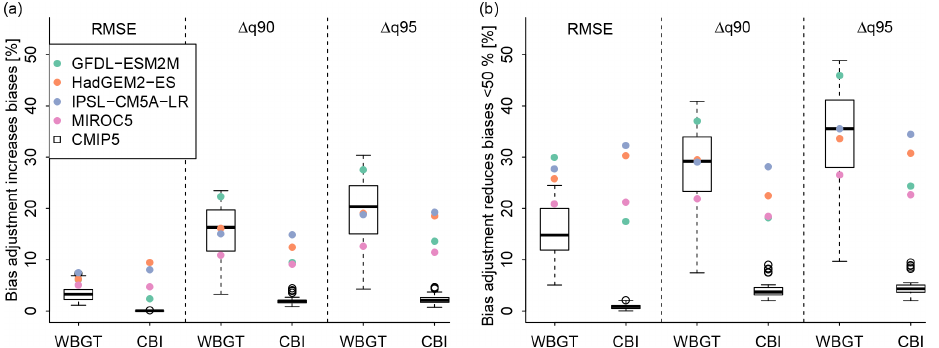
Figure 3. Fraction of grid points for which UQM increases bias (a) or does not result in a reduction of more than 50% in biases (b) of modeled hazards. Box plots represent the CMIP5 multimodel ensemble after UQM and highlight the median (horizontal line), interquartile range (box), 1.5 times the interquartile range (whiskers) and outliers (points). Colored dots represent the results for the ISIMIP2b bias adjustment applied to the four GCMs used in ISIMIP2b. Shown are the metrics RMSE between empirical cumulative distribution functions and absolute differences in the 90th ( (cid:49)q 90) and 95th percentile ( (cid:49)q 95) between hazard indicators computed from (bias-adjusted) model outputs and observations (ERA-Interim for CMIP5 and EWEMBI for